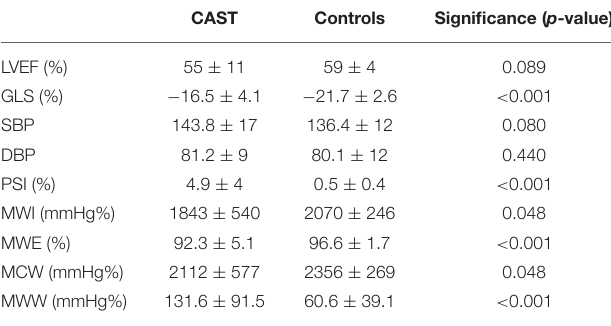
TABLE 2 | Echocardiographic